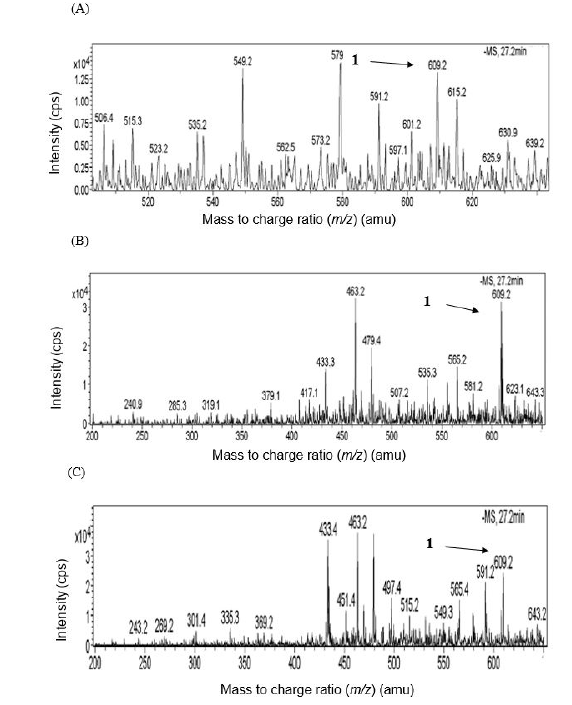
Figure 6. ESI-MS analysis of rutin in E. sonchifolia . 1. rutin, with m/z 609.2 [M-H] - , indicated above at retention time 27.2. (A) control plants, (B) heat-stressed plants, and (C) drought-stressed plants.